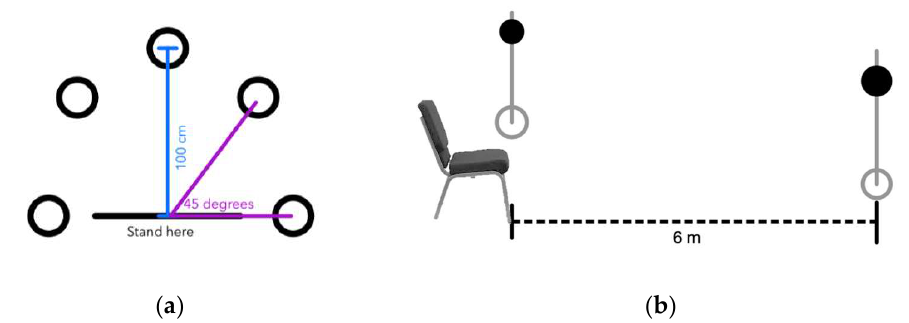
Figure 1. Diagrams of Reactive agility tests: ( a ) Semi-circle drill ( b ) Get-up-and-go drill.